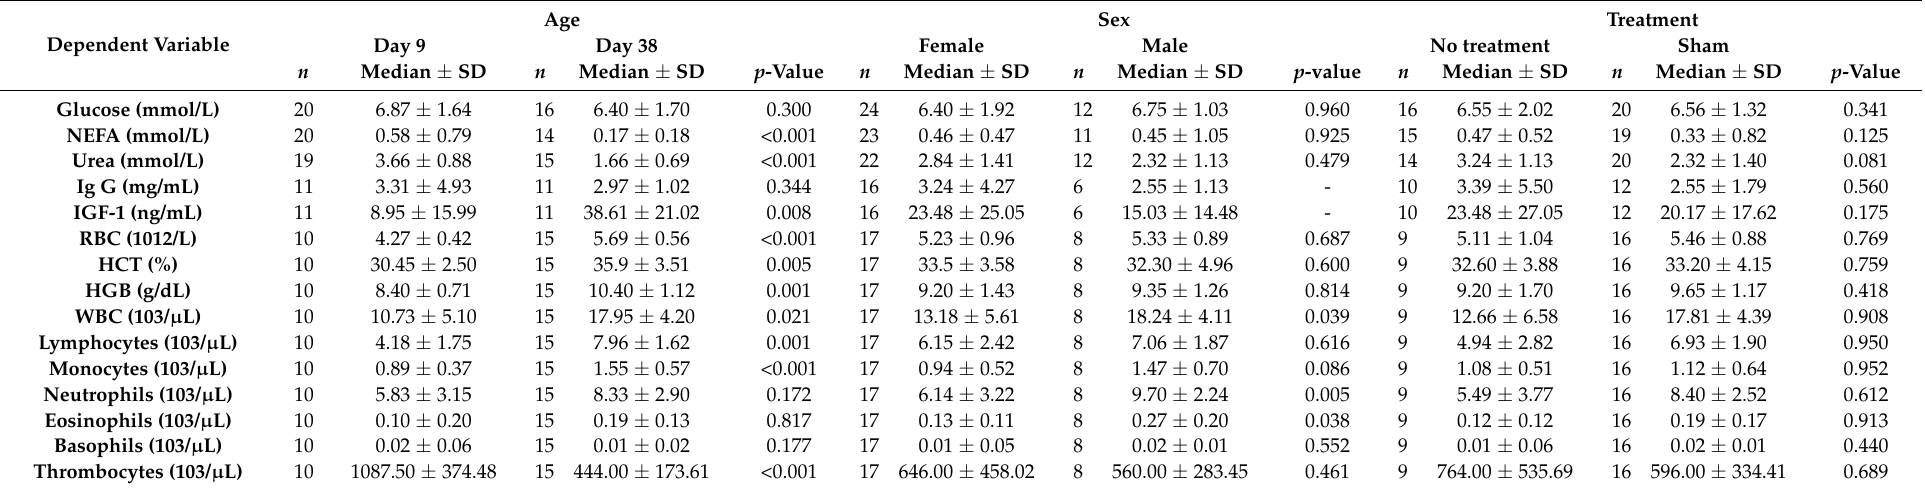
Table 2. Blood values (median ± SD) of glucose, non-esterified fatty acids (NEFA), urea, immunoglobulin G (IgG), insulin-like growth factor 1 (IGF-1), red blood cells (RBCs), hematocrit (HCT), hemoglobulin (HGB), white blood cells (WBCs), lymphocytes, monocytes, neutrophils, eosinophils, basophils and thrombocytes, presented by age, sex and treatment from selected low birth weight piglets (linear mixed models, Tukey post-hoc analysis, p ≤